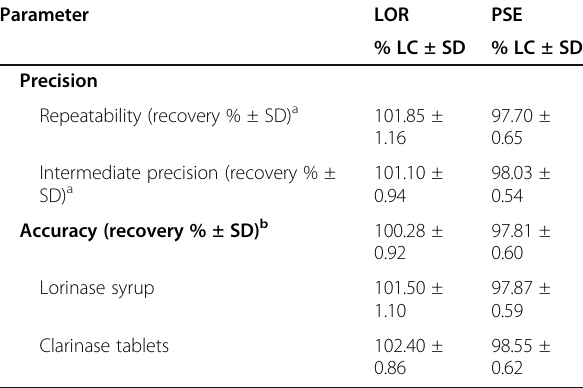
Table 5 Reduced response models and statistical parameters